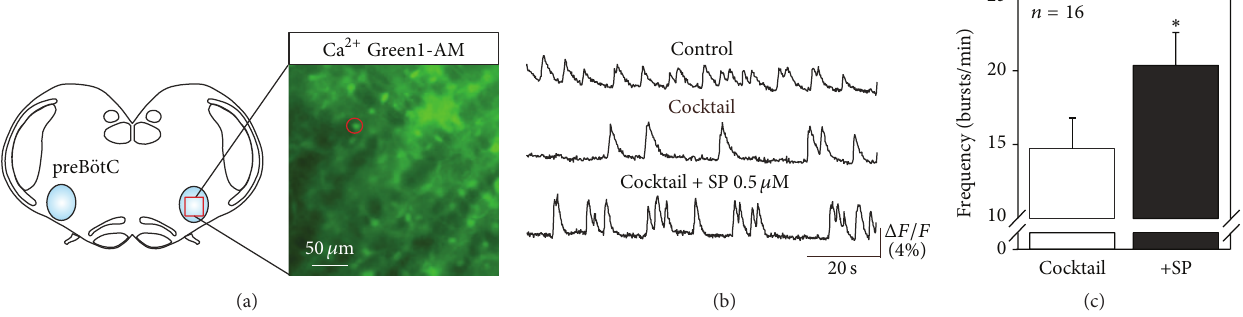
Figure 4: Embryonic respiratory pacemaker neurons are sensitive to SP. (a) Schematic of an embryonic transverse slice showing location of a preB¨otC network pacemaker neuron monitored with calcium imaging. (b) Traces of calcium transients recorded in the cell in control conditions (top), after synaptic isolation from the other network elements (middle, cocktail) and in the presence of 0.5 𝜇 M SP (bottom). After isolation, the frequency of the cell’s ongoing rhythmic activity was significantly increased in the presence of SP. (c) Pooled data showing mean frequency ( ± SEM) of activity expressed by 16 pacemaker neurons in cocktail (white bar) and under the presence of SP (black bar). Asterisk: 𝑃 < 0.05 .